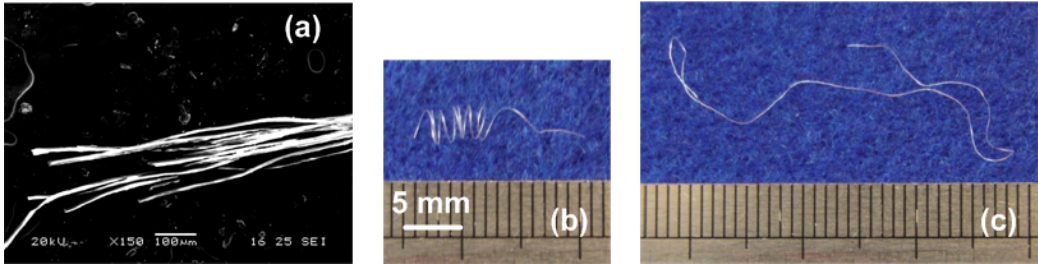
Figure 19. Water-responsive SME in cocoon silk. ( a ) Scanning electron microscope image of a string of commercial silk. Each piece of silk is about 10 μ m. The scale bar is 100 μ m; ( b ) after being programmed into spiral spring shape; and ( c ) after immersing into room temperature water for shape recovery.